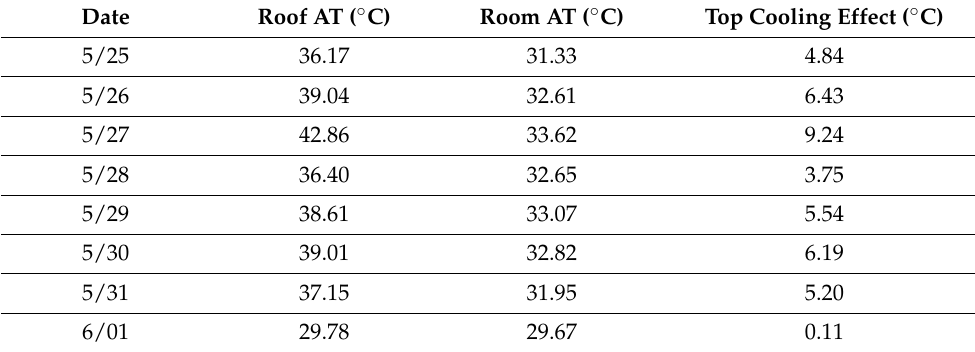
Table 7. Ambient temperatures of the ecological terrace during 12:00–13:00.